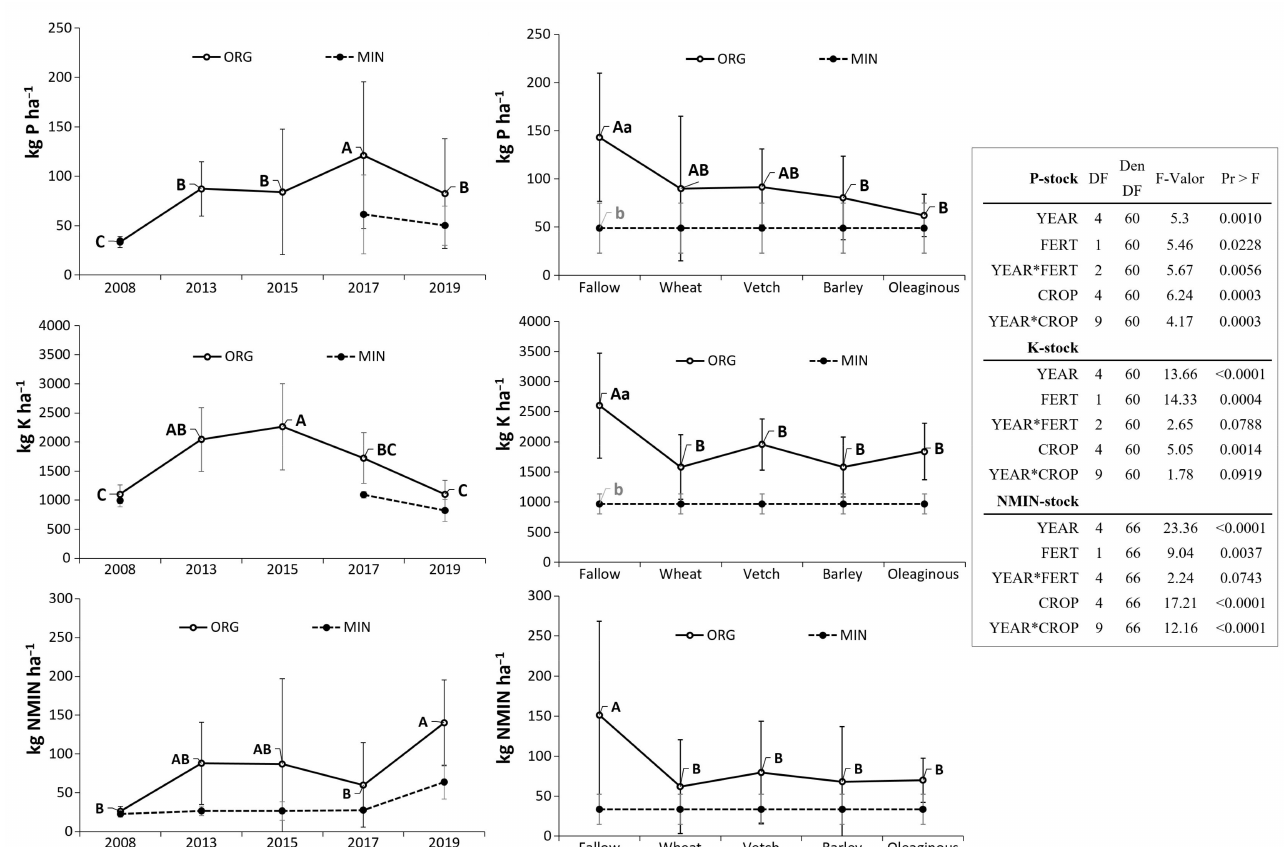
Figure 4. Influence of Year and Crop on the stocks of P, K and NMIN (NO 3 -N + NH 4 -N) under ORG compared to the MIN treatment. Bars indicate the standard deviation of the data. Uppercase letters indicate that means are significantly different among years and lowercase letters indicate that means are different between fertilization ( p < 0.05). Analysis of variance (PROC MIXED) for evaluating YEAR, fertilization (FERT) and CROP influences on soil nutrient stocks. P, K and NMIN stocks were log-transformed to meet the assumptions of residual normality and homogeneity of variance. The interaction FERT*CROP lacked of Degrees of Freedom for the